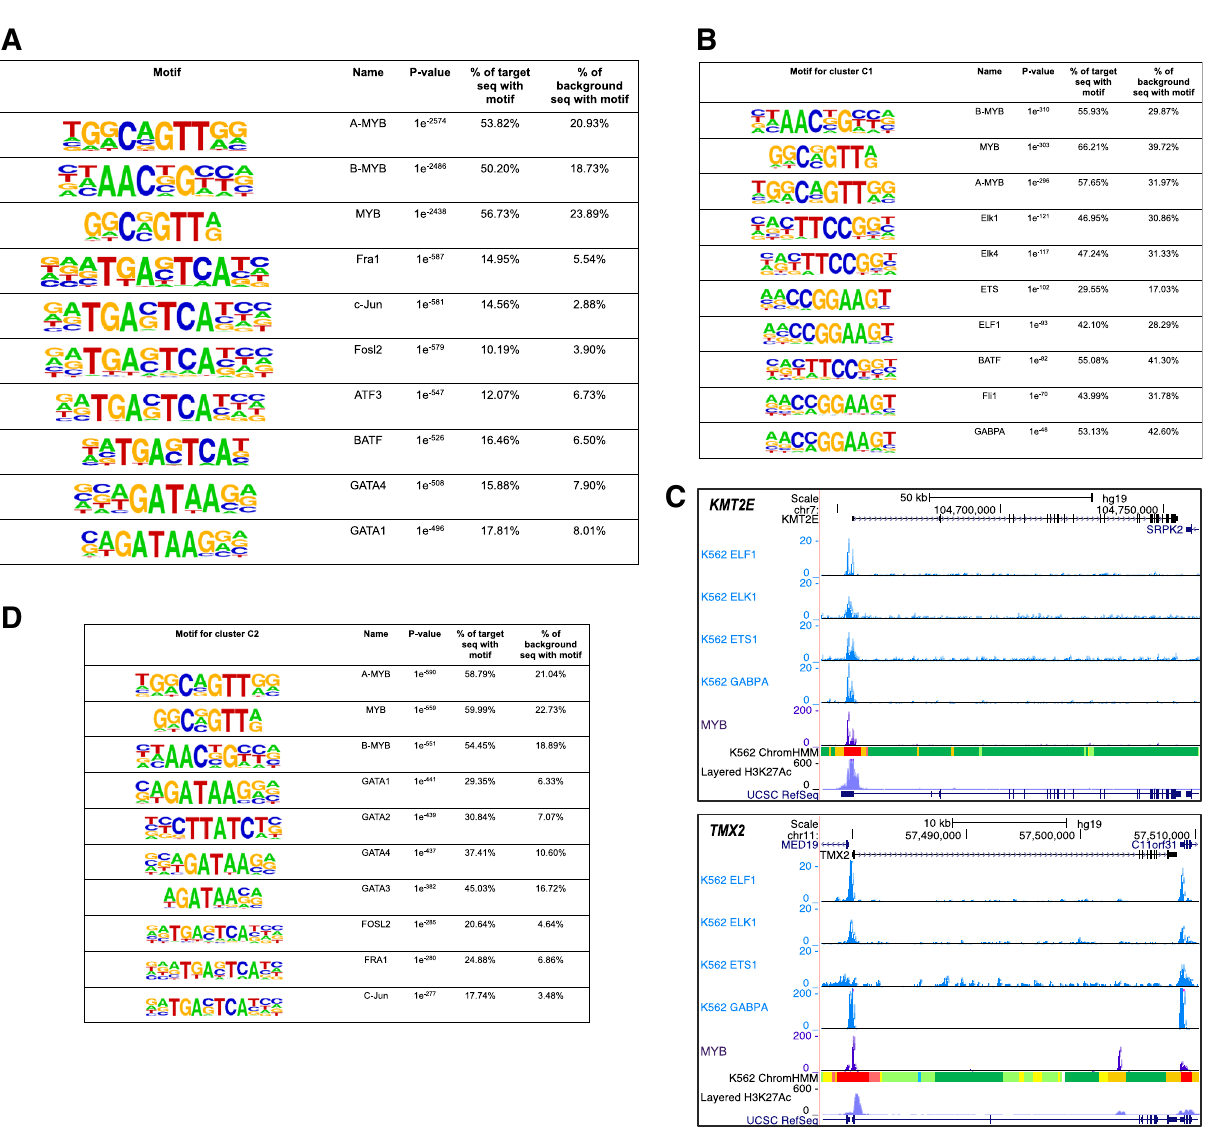
Figure 4. Identified MYB ChIP-seq peaks are evidence for its direct binding. ( A ) Enrichments of known motifs at MYB occupied regions from three biological replicates in K562 cells (n = 22,780). ( B ) Enrichments of known motifs at MYB occupied regions belonging to MYB cluster C1 from Fig. 3A. ( C ) Occupancy of MYB at KMT2E and TMX2 loci. Publicly available ChIP-seq tracks for ETS-related factors from K562 cells are displayed along with the current MYB ChIP-seq data. Visualization of the tracks were made using the UCSC genome browser 76 (https:// genome. ucsc. edu/) by creating a UCSC session containing the K562 control and MYB ChIP- seq bigwig files from the current study along with the bigwig files of publicly available K562 ChIP-seq data for ELF1 (ENCFF921NSY), ELK1 (ENCFF390PFQ), ETS1 (ENCFF448HHF), and GABPA (ENCFF450AAJ). ( D ) Enrichments of known motifs at MYB occupied regions belonging to MYB cluster C2 from Fig. 3A. Enriched binding motifs for panel A, B and D are arranged in descending order based on their p-value. Motif analyses around MYB binding sites were made using the HOMER program version 4.9 82